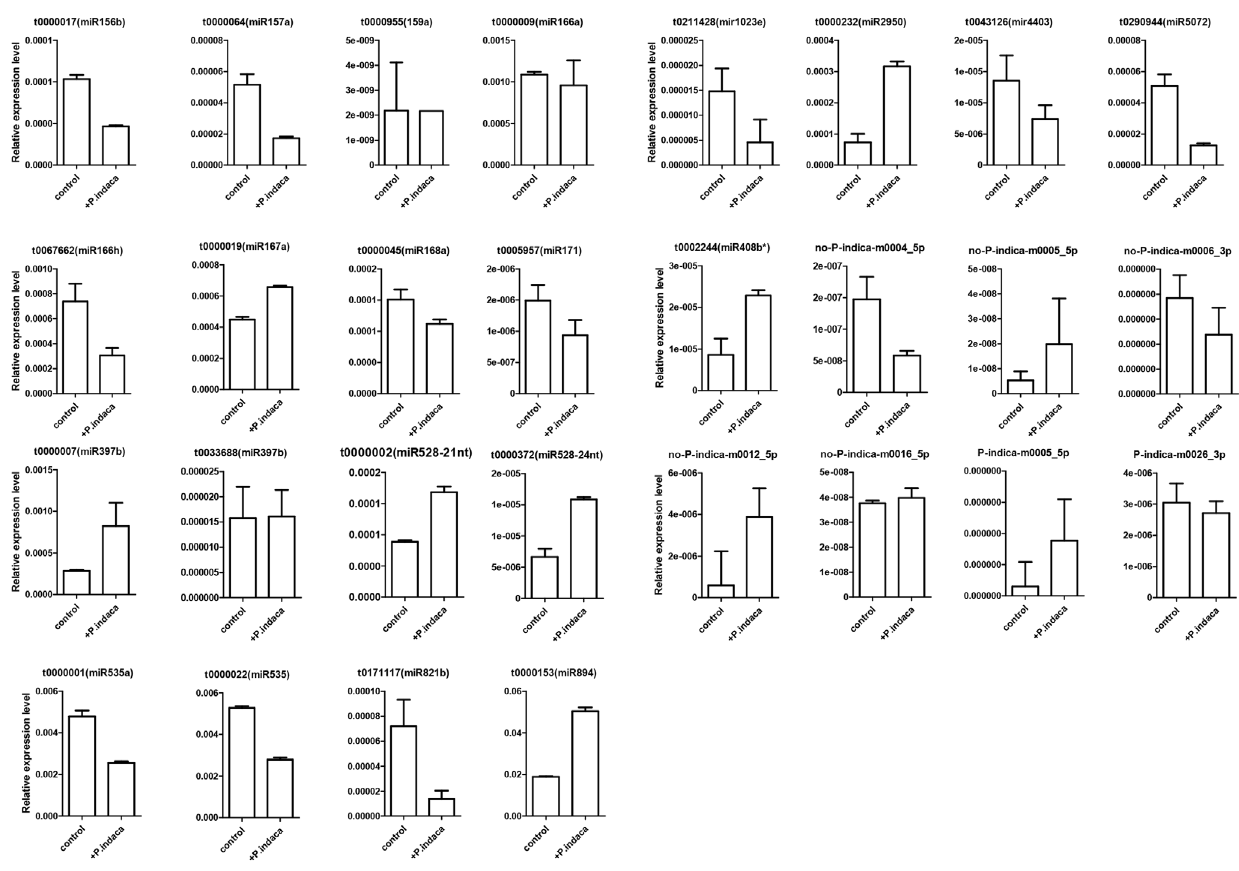
Figure 3. Expression analyses of miRNAs in Oncidium orchid ± P.indica by qPCR. Roots colonized 6 P. indica for 8 weeks were sampled. Data represent the mean 6 SD of 3 replicates and normalization by 5.8S rRNA. e represents the decimal point. * indicates antisense strand; no P. ind i ca indicates that the novel miRNAs were specifically found in the –P. indica orchid library. P. indica indicates that the novel miRNAs were specifically found in the + P. indica orchid library.